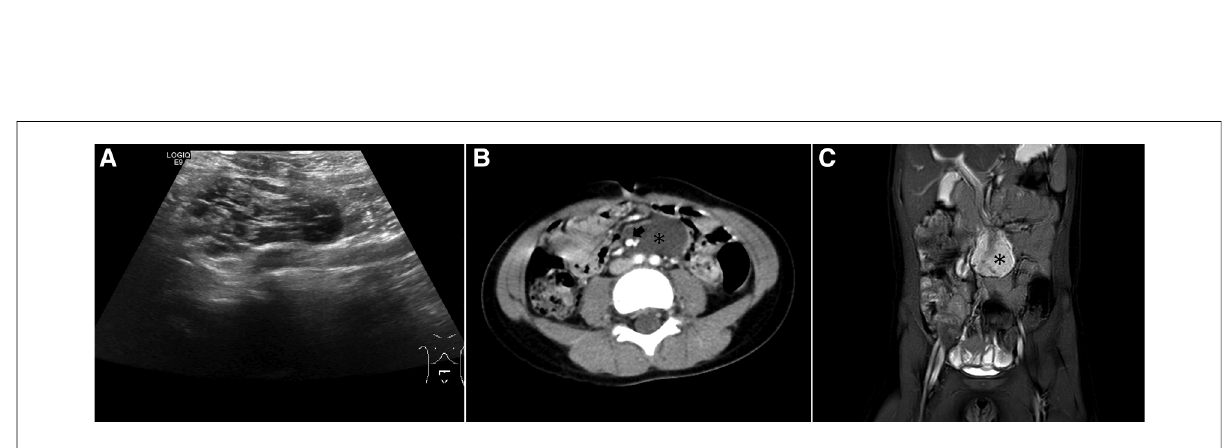
FIGURE 2 Imaging of a patient with a complicated cyst located at the root of the intestinal mesentery. ( A ) Sonograph demonstrating a hypoechoic cyst with multiple vehicles and internal septations; ( B ) enhanced CT scan showing a low-density cyst (asterisk) located at the root of the intestinal mesentery and surrounded mesenteric vessels (arrow); ( C ) MRI showing a cyst with signi fi cant signal intensities on T2-weighted imaging.